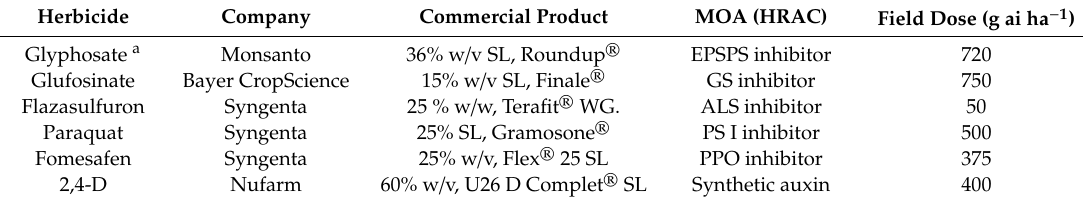
Table 1. Main characteristics of the herbicides used in this